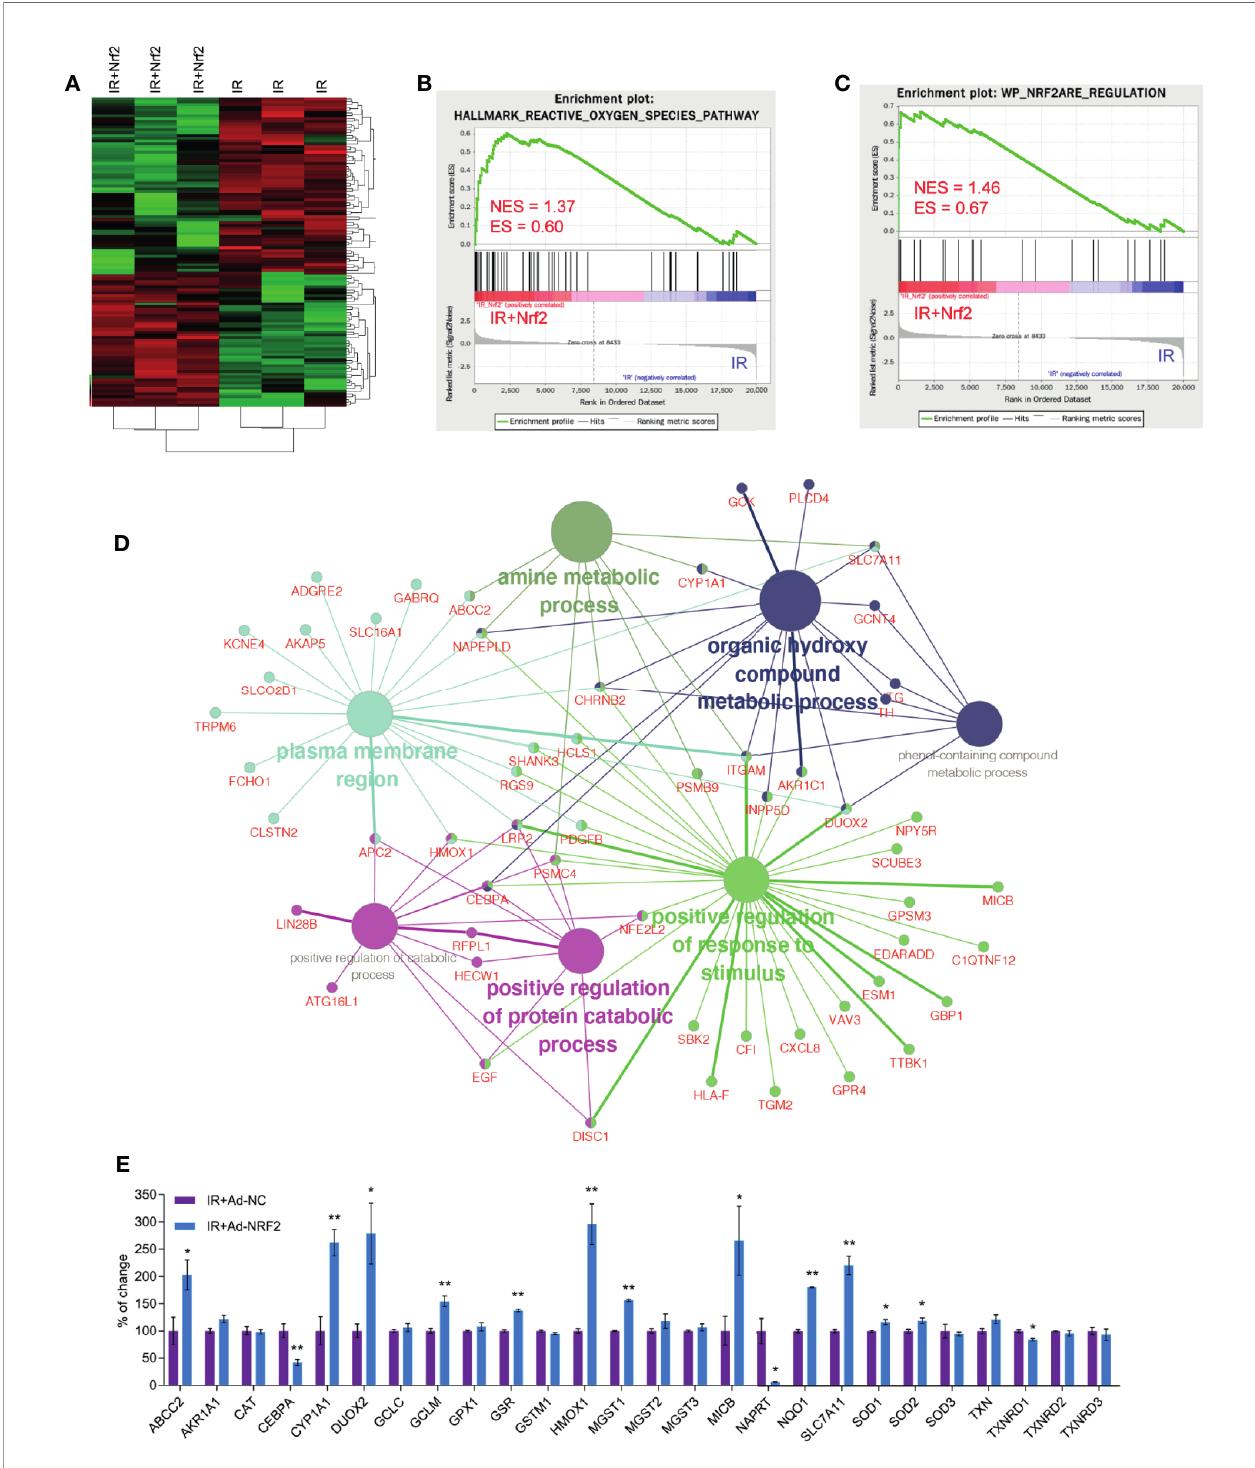
FIGURE 5 | Nrf2 changes the gene expression pro fi le in skin cells after IR. Transcriptome sequencing was performed for HaCaT cells overexpressing Nrf2. (A) Heatmap of cluster analysis based on sequencing results. (B) GSEA plot showing normalized enrichment scores (NESs) for reactive oxygen species pathway signatures using RNA-seq data from IR+Nrf2- and IR-treated skin cells. (C) GSEA plot showing normalized enrichment scores (NESs) for Nrf2 ARE regulation signatures using RNA-seq data from IR+Nrf2- and IR-treated skin cells. (D) GO enrichment analysis of differentially expressed upregulated and downregulated genes based on RNA-seq data with adjusted P-values. (E) Real-time PCR analysis of the mRNA levels of Nrf2 downstream genes after IR+Nrf2 and IR treatment. * means p < 0.05, ** means p <